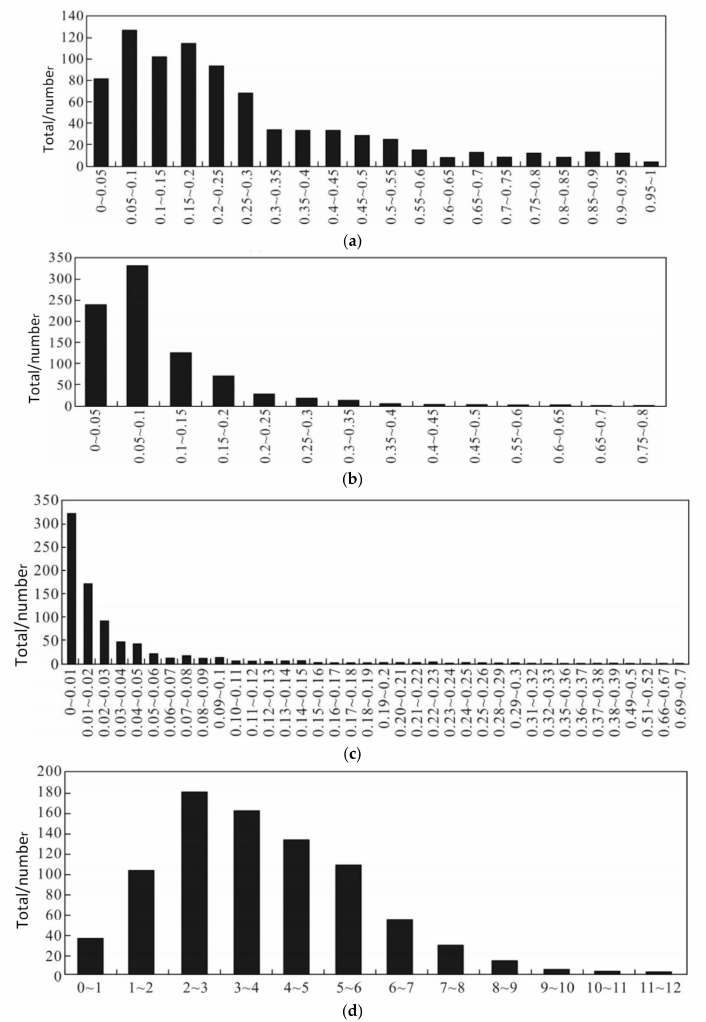
Figure 11. Characteristic analysis of text area in ICDAR2013 database. ( a ) Width of text area/width of full image, ( b ) height of text area/width of full image, ( c ) text regional area/full image area, and ( d ) width of text area/height of text